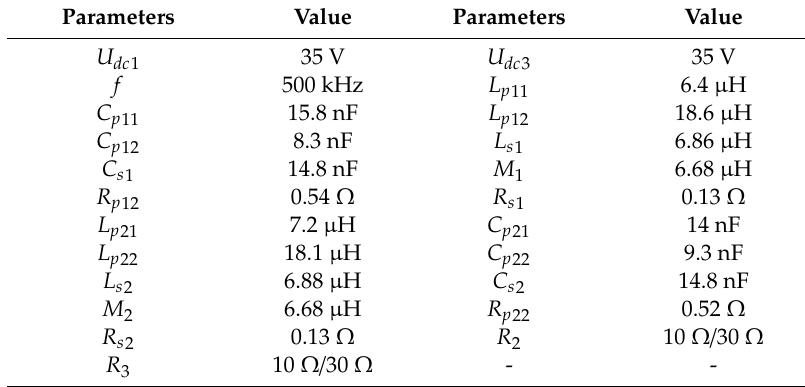
Figure 12. Experimental setup. Table 3. Experimental